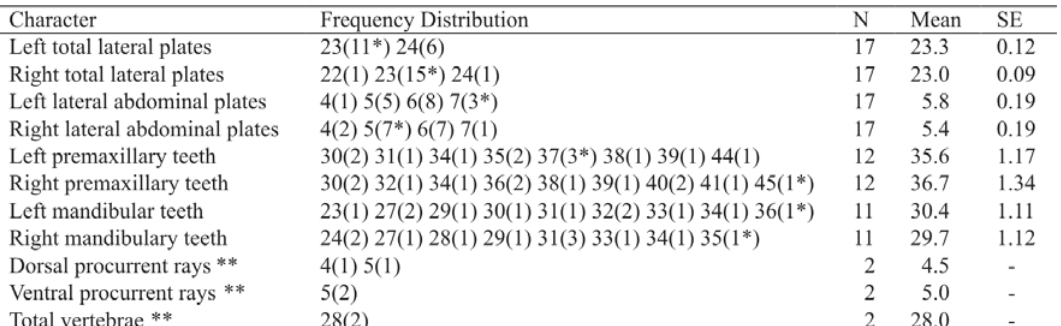
Table 2. Frequency distribution and summary statistics for meristics of Otocinclus cocama . Holotype values are marked with an asterisk. N = number of individual counted, SE = standard error of the mean; ** = counted in